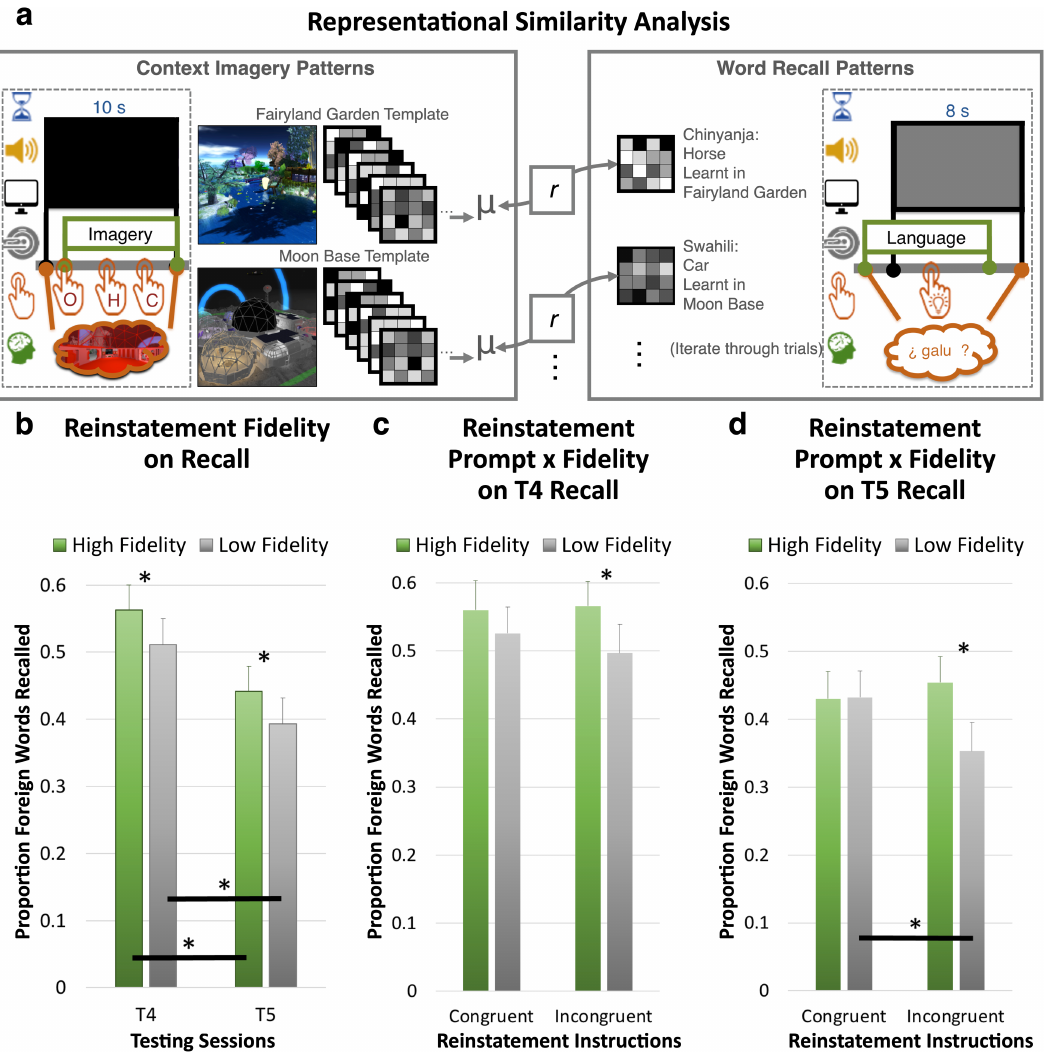
Fig. 5 fMRI experiment: representational similarity analysis procedure and results. After feature selection, fMRI activity patterns from each participant ’ s top 2000 voxels were used in a within-subject representational similarity analysis (RSA); RSA output was used to analyse verbal recall data. a RSA computed the correlations between activity patterns for each word during covert word recall (right) and the context template (left) of the word ’ s original learning context. The context template was an average of all the imagery patterns for a given context. The resulting correlation values were then used to divide recall trials into high fi delity vs low fi delity reinstatement trials, and verbal recall results were examined for each trial type. The effects of reinstatement prompt (congruent vs. incongruent) and/or reinstatement fi delity (high vs. low) on recall are plotted respectively for: ( b ), all non-VR tests (T4 and T5; collapsed across reinstatement prompt conditions), ( c ), short- delay non-VR test (T4), and ( d ), one-week-delayed non-VR test (T5). * denotes statistical signi fi cance for pairwise tests; see main text for description of interaction effects. Image attribution: The VR environments depicted here were created by J.K.-Y.E. or by Forde Davidson as commissioned by the research team, or were from the OpenSim community shared under the Creative Commons 0 License. The icons used were either created by J.K.-Y.E. or were modi fi ed from stock icons in MS PowerPoint or public